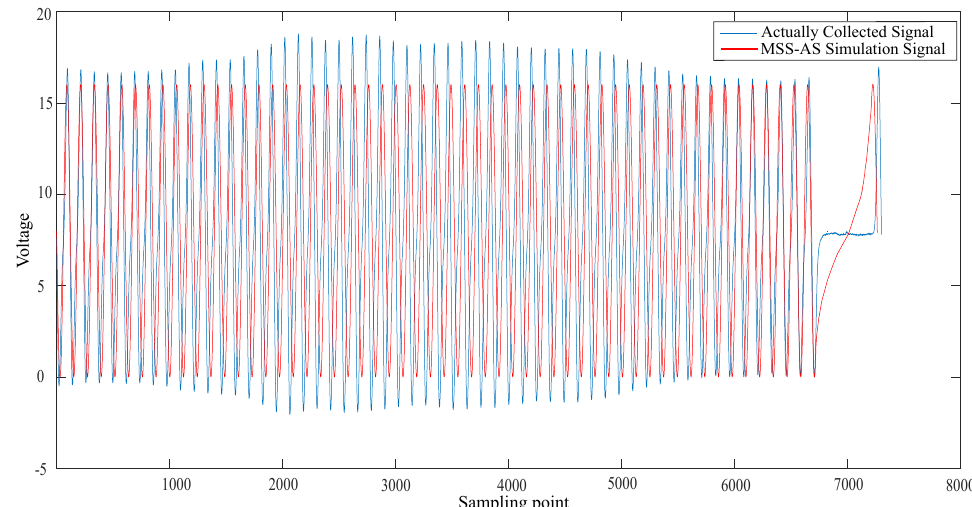
Figure 20. Comparison of the MSS-AS simulation and actually collected signal.